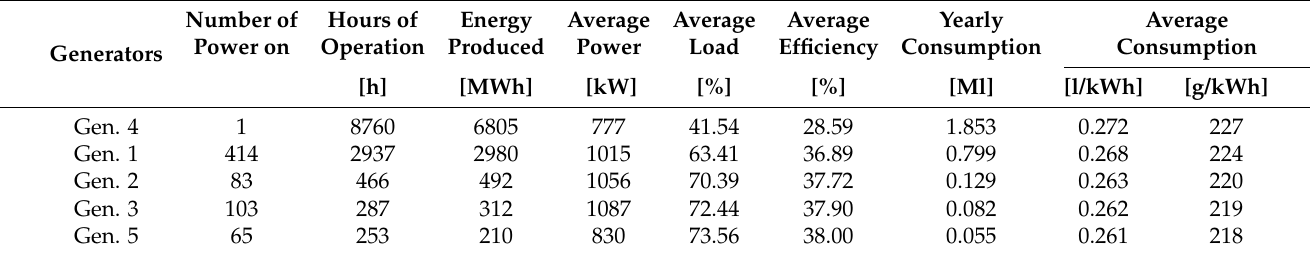
Table 23. Forecast of the annual operating data of the generators to 2030 with the integration of BESSs and RESs to 300% of the objectives of the Decree.